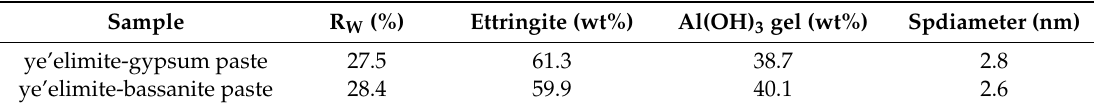
Table 3. Selected results for the synchrotron PDF analysis of the ye’elimite pastes in the 1.5–35 Å r-region. Sample R W (%)